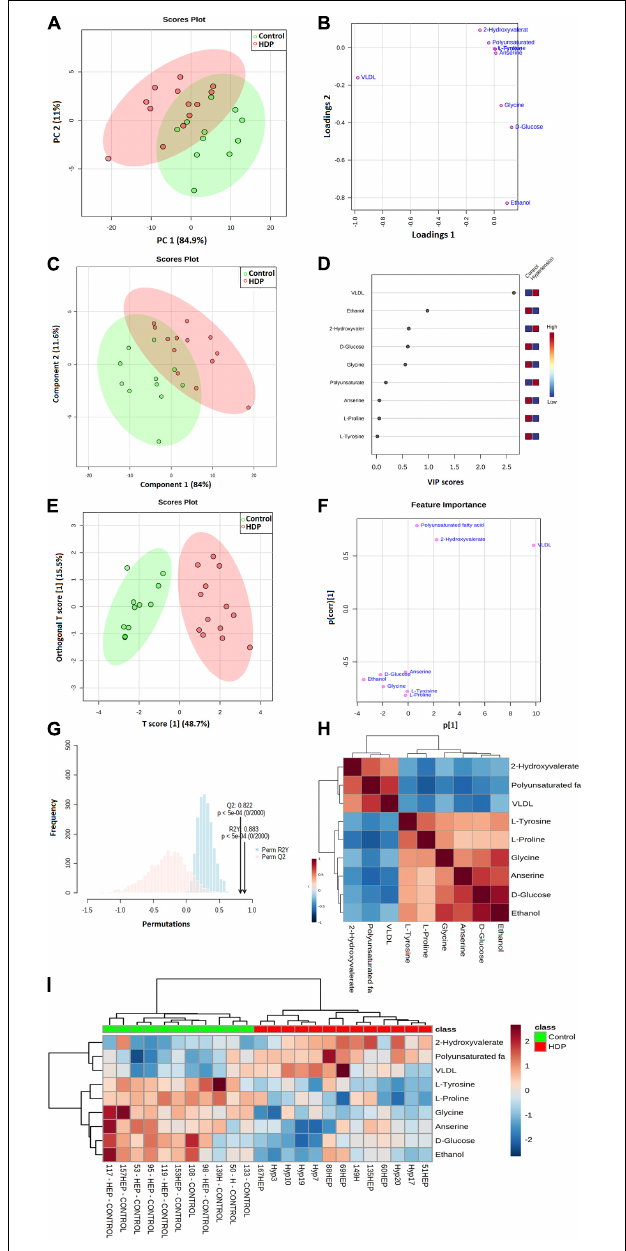
FIGURE 4 | 1 H NMR metabolism analysis from exosome-enriched plasmas. (A) Score plot, from unsupervised PCA, with the first two principal components from PCA of exosome-enriched plasma metabolites. Each axis indicates the percentage of total variability explained by the component; (B) PC loadings; (C) PLS-DA score plot with the first two principal components from PCA of exosome-enriched plasma metabolites; (D) PLS VIP; (E) The model OPLS-DA shows the predictive component vs. orthogonal component; (F) Feature importance; (G) Permutation tests ( n = 2,000); (H) Correlations heatmap; (I) Clustering analysis and heatmap visualization.